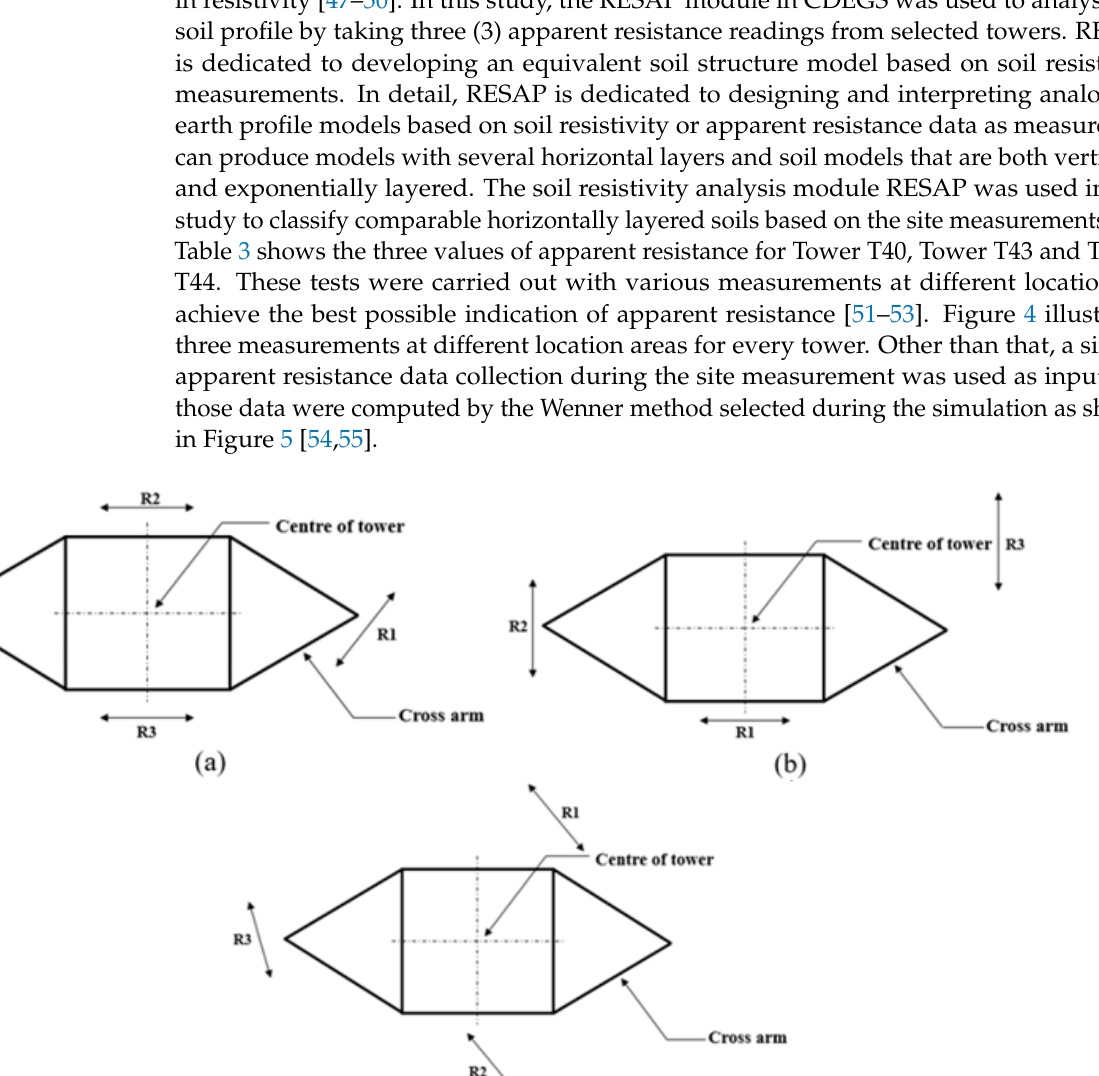
Figure 5. Wenner measurement method. 2.2.2. Earthing Model The effectiveness of the TL efficiency can be greatly improved by a good earthing system design [56]. Typically, the nature of the earthing system design has a relationship to the shape of the tower base. In a high soil resistivity area, a unique earthing design should be applied to the tower base. This section demonstrates the detailed simulation model for the earthing system design. The modelling of the earthing design was devel ‐ oped using SESCAD and implemented by the MALT module to determine the earth re ‐ sistance. In creating an earthing design model, four (4) main steps in the MALT module solution were presented as shown in Figure 6.